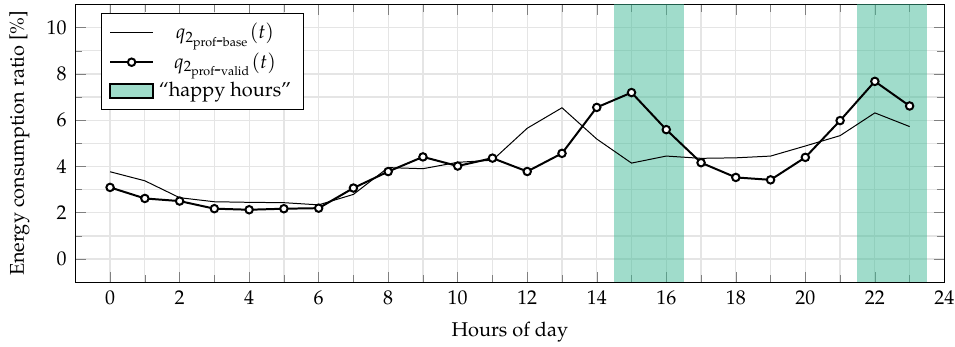
Figure 10. Visual comparison between hourly demand profiles.